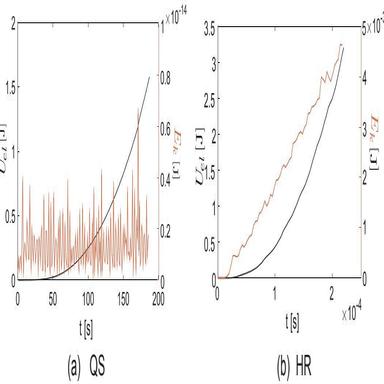
Strain and kinetic energy terms for (a) QS and (HR) loadings (specimen size A).